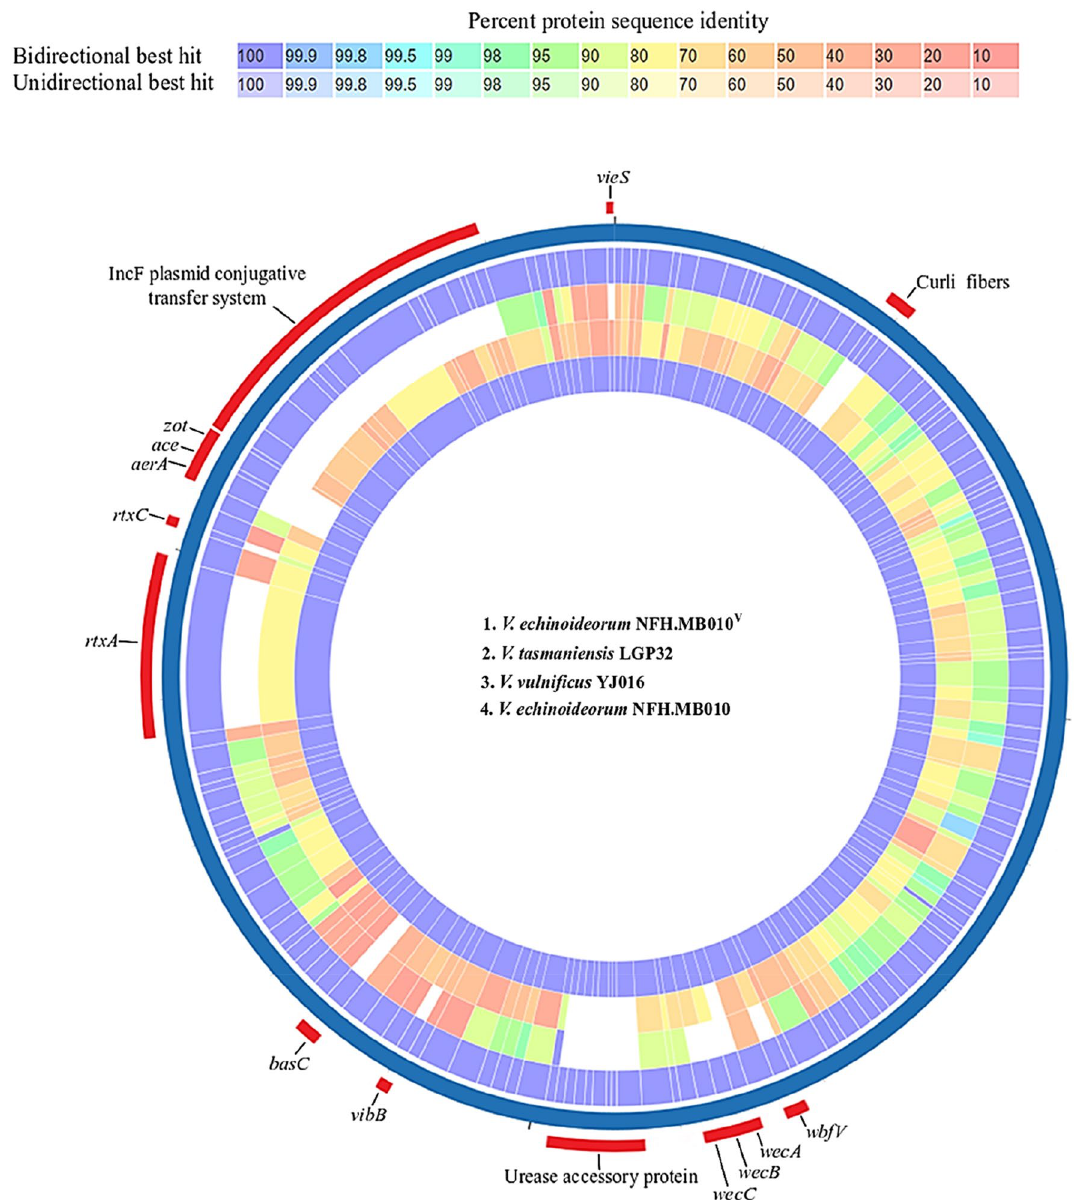
Figure 5. A circos plot featuring the proteome comparison of predicted virulence genes of V. echinoideorum . From the outer ring to the inner ring: V. echinoideorum , V. tasmaniensis LGP32, V. vulnificus YJ016, and V. echinoideorum (as control replicate). Only distinguished features between these strains are